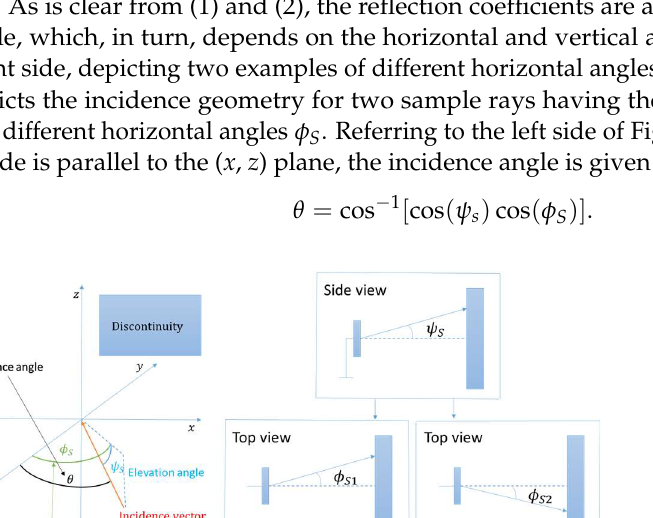
Figure 7. Trend of the absolute value of the reflection coefficient (both TE and TM cases) at 6 GHz as a function of the incidence angle, for different discontinuities: air to ground (asphalt) and build- ing (concrete/brick wall and glass slab). For a single discontinuity, the reflection loss (in dB) is simply calculated as 𝐿 (cid:3019) = −10 log(|Γ(𝜃)| (cid:2870) ). (4) The combination of multiple reflections is explained in Section 5.2. Besides reflections, in an urban environment, diffraction from obstacles plays a key role in determining the overall loss of the wave on its way to the satellite. Following the method described in [11], the knife-edge model is implemented to consider the diffraction loss: an obstacle, such as a building, is approximated by a knife edge of negligible thick- ness. The calculation of the diffraction loss requires evaluating Fresnel’s integral, which could be quite time consuming, so the proposed model uses the simple (yet effective and accurate) expression of the diffraction loss L D (in dB) described in Recommendation ITU- R P.526-15 [12]: